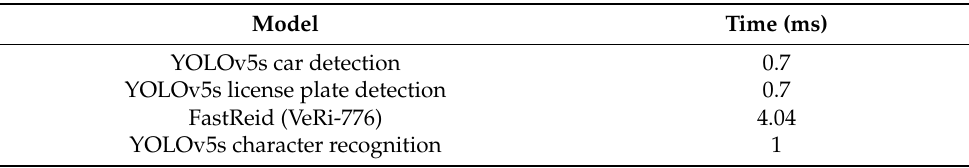
Table 8. Inference time in visual